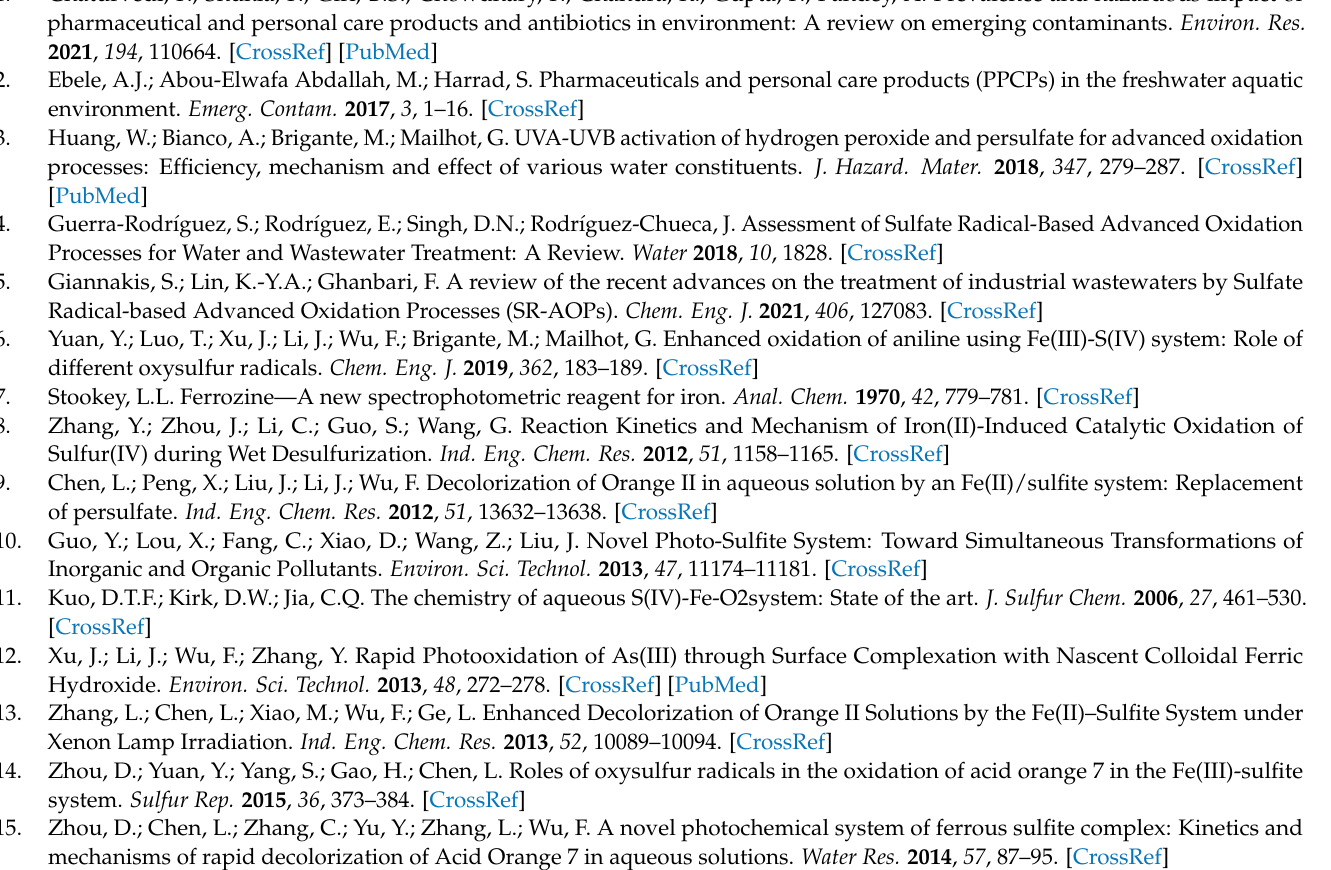
Figure S3: Effect of Fe(III) concentration on PARA degradation with UVA irradiation in